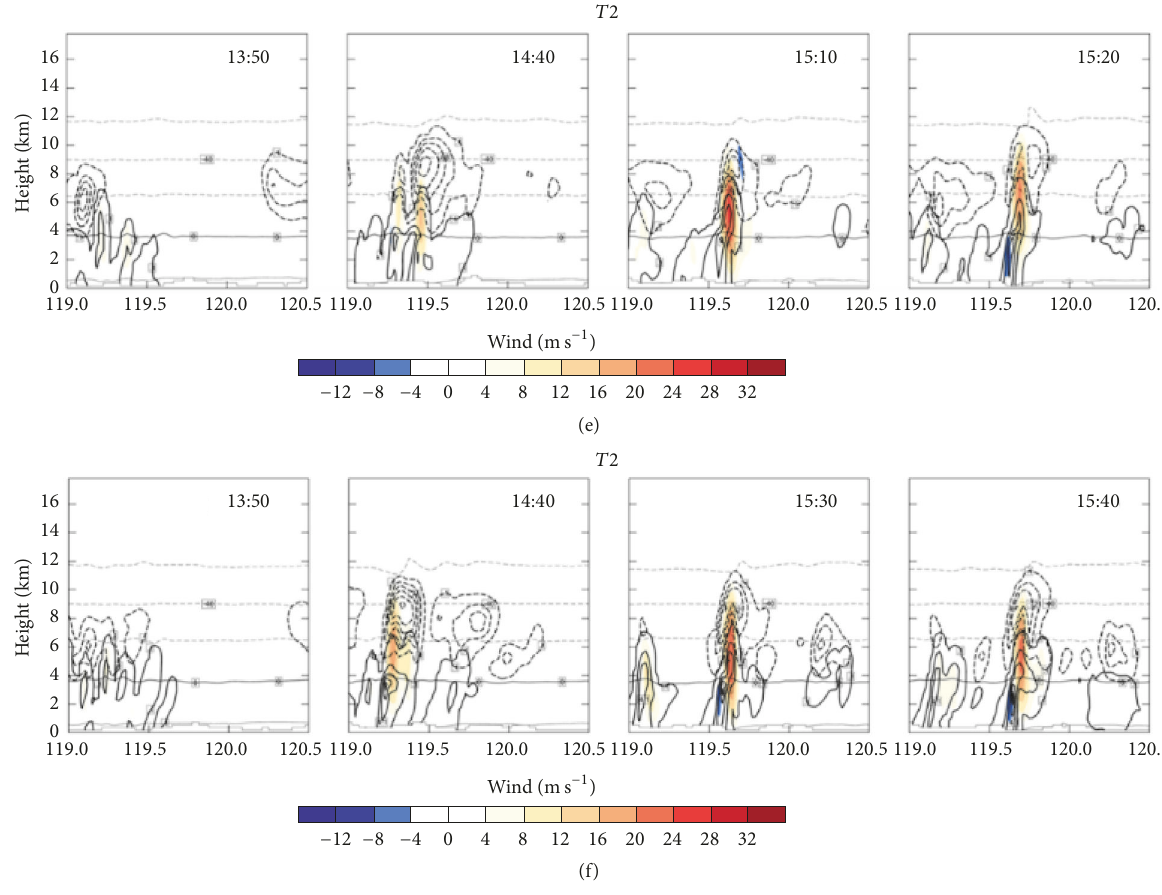
Figure 9: Cross section of the simulated rain water mixing ratio (solid line, minimum 0.1 g ⋅ kg −1 , interval 2.5 g ⋅ kg −1 ), snow water mixing ratio (black dotted line, minimum 0.1g ⋅ kg −1 , interval 0.3g ⋅ kg −1 ), and updraft (colored) and isothermal line (dashed gray line) in latitudinal direction: (a) original; (b) Philips; (c) Cooper; (d) Fletcher; (e) Chi NJ; and (f) Chi Mt.